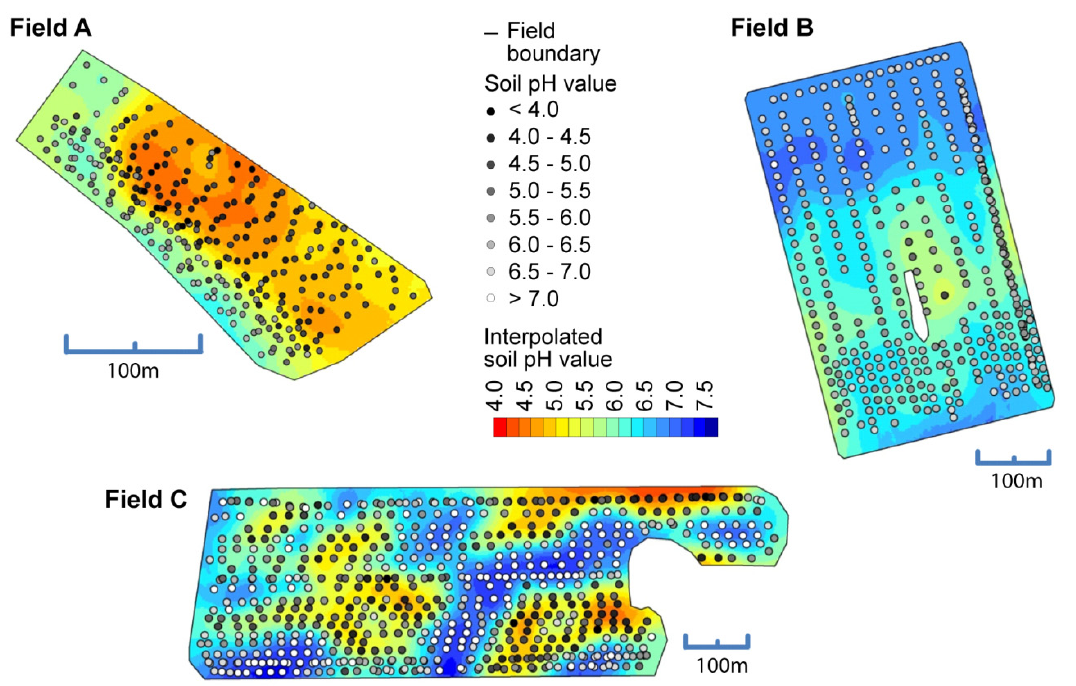
Figure 10. Soil pH maps derived from on-the-go sensor readings after calibration to pH (CaCl ). Dots, indicating the measurement locations, are superimposed on raster maps 2 obtained by Kriging